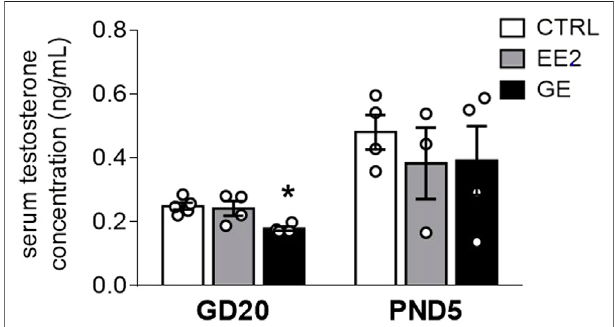
FIGURE 1 | Effects of in utero exposure to EE2 or GE on steroidogenesis. Mean testosterone concentration measured within pooled serum of males sampled on GD20 or PND5 following in utero exposure to either vehicle (CTRL), ethinylestradiol (EE2) or genistein (GE) are represented as the mean ± SEM. Individual values are also displayed on the graph (n = 3-4 from different litters/group). * indicates a p -value < 0.05 when compared to